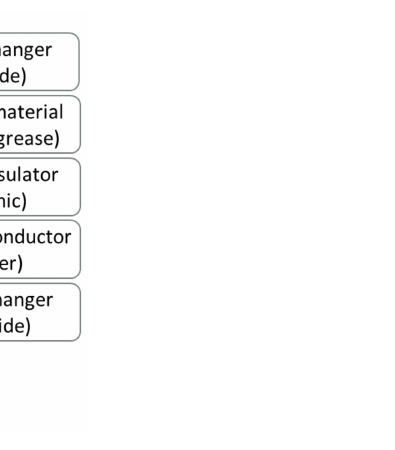
Figure 8. Integration of thermoelectric module in a thermoelectric